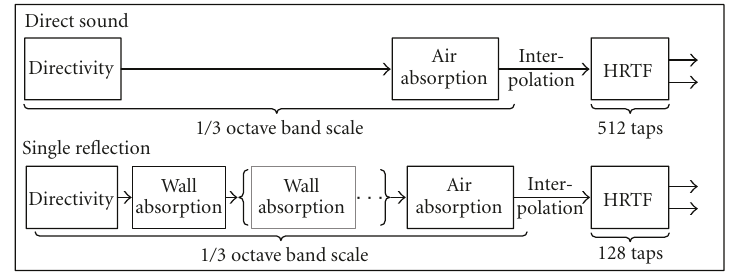
Figure 7: Filter elements for direct sound and